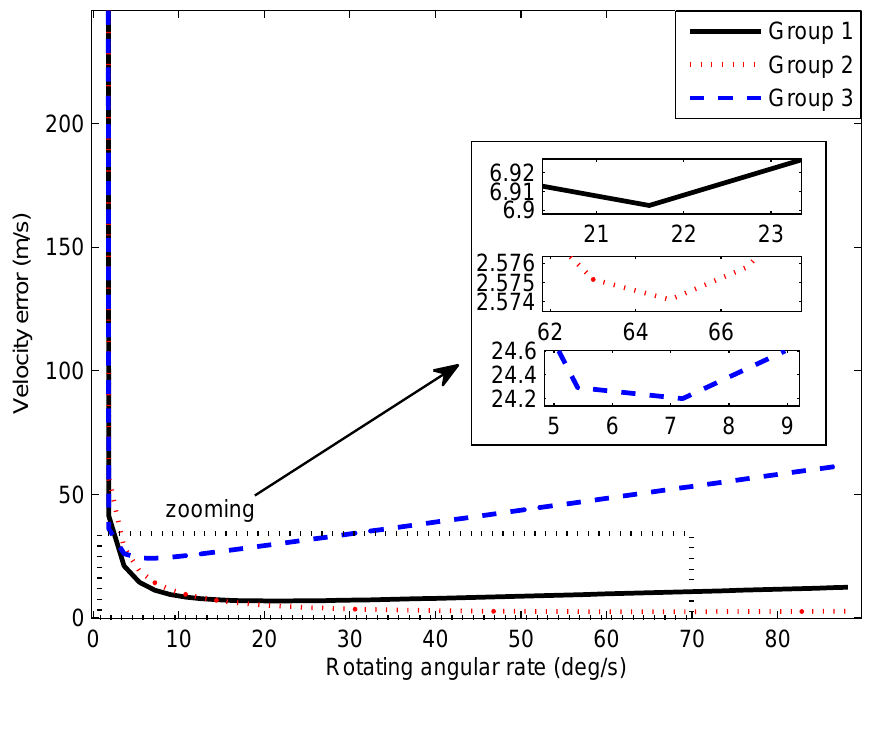
Figure 7. The relationship curves between the velocity errors and the rotating rates.